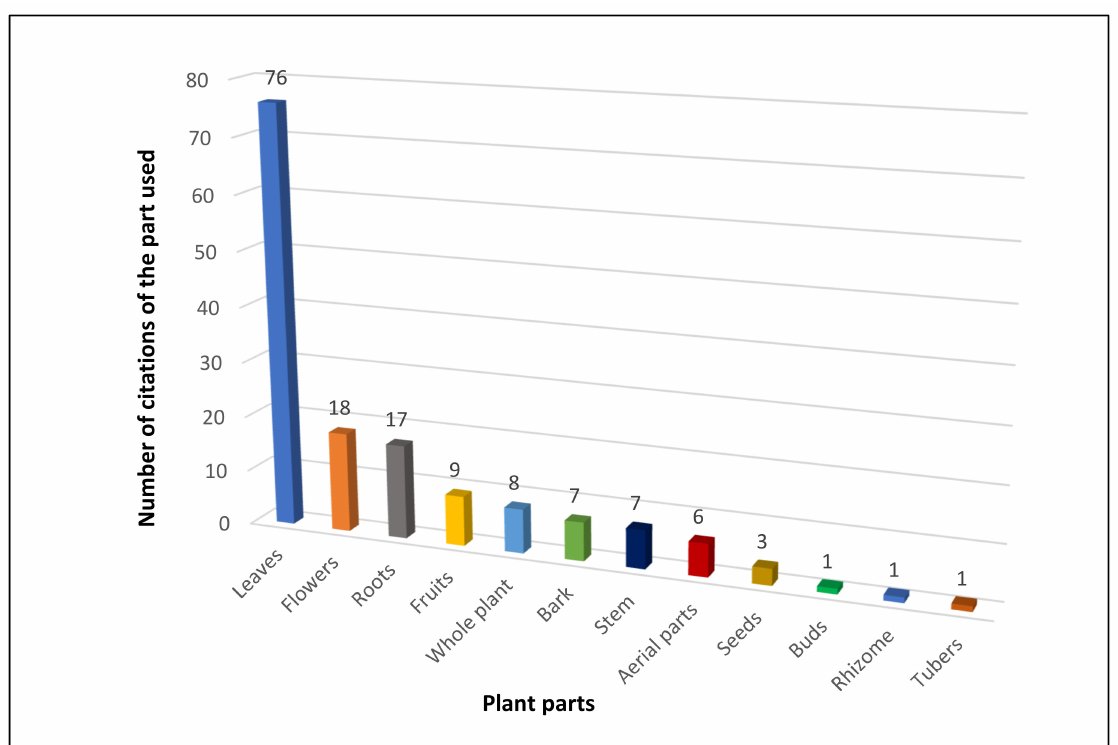
Figure 4. Representation of the number of citations of plant parts